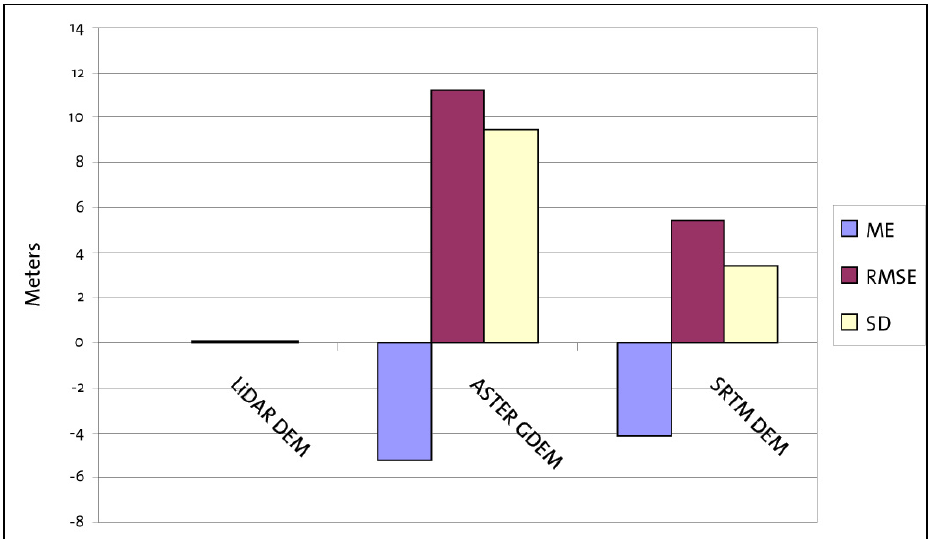
Figure 7. Error statistics.